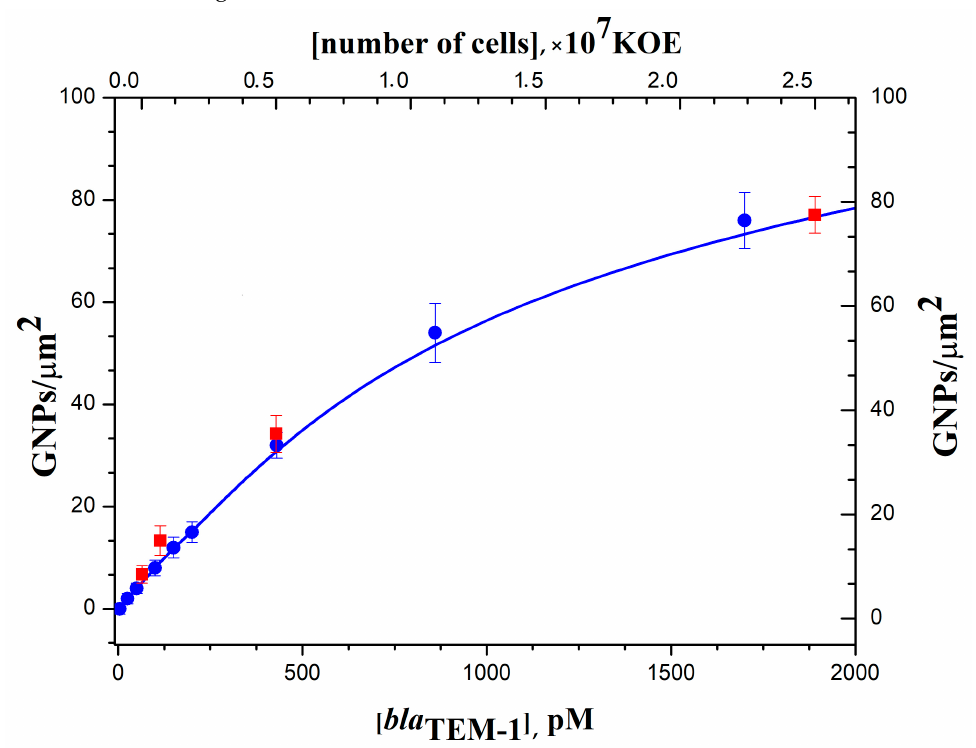
Figure 7. Determination of specific mRNA of the blaTEM-1 in RNA transcripts isolated from E. coli cells by sequential reverse transcription and PCR followed by hybridization and digital detection of GNPs (red). Calibration curve for the determination of blaTEM-1